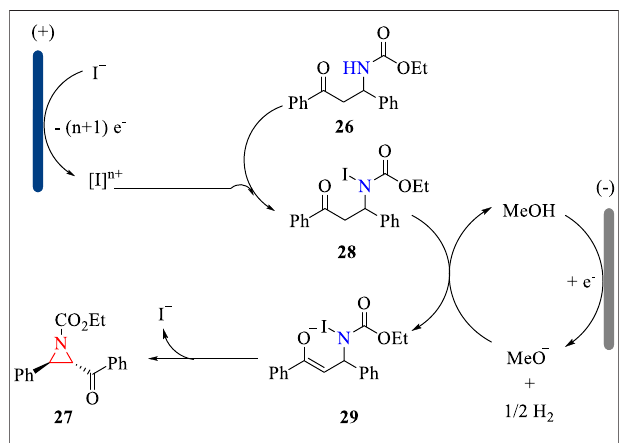
SCHEME 10 | The reaction sequence for the electrochemical formation of